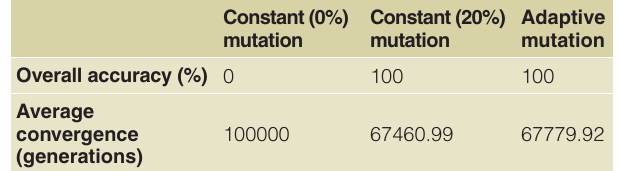
Table 1. Summary of results from solving the N-Queens problem using various mutation rates.